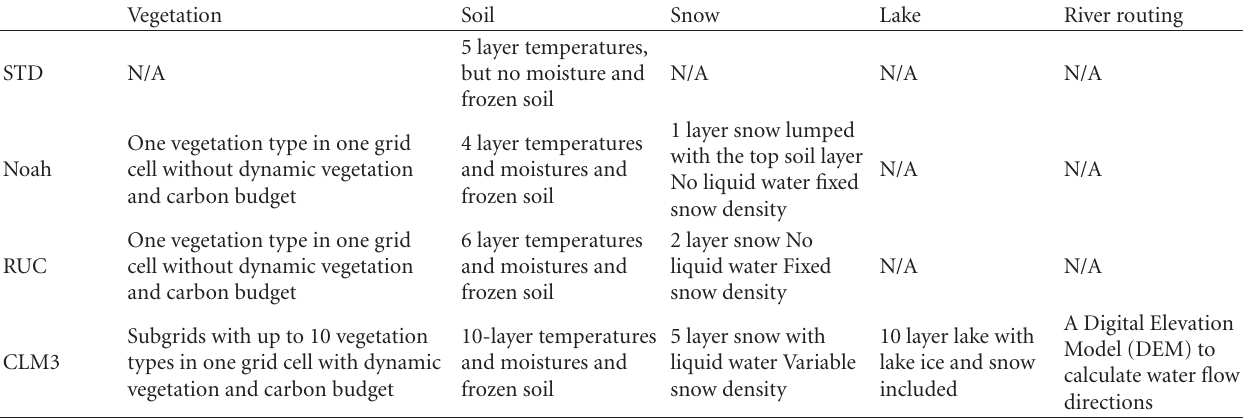
Table 1: Comparison of the STD, Noah, RUC, and CLM3 land surface schemes in